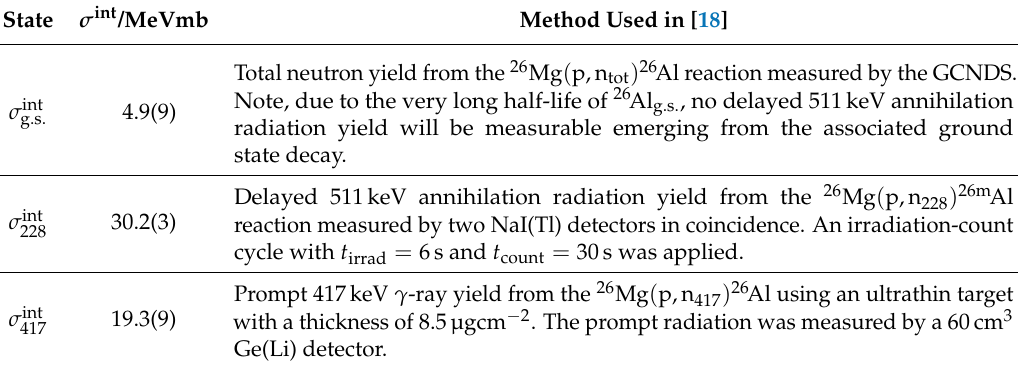
Table 1. Calculated integral cross sections σ int and methods used to measure σ ( E ) for the lowest three states in 26